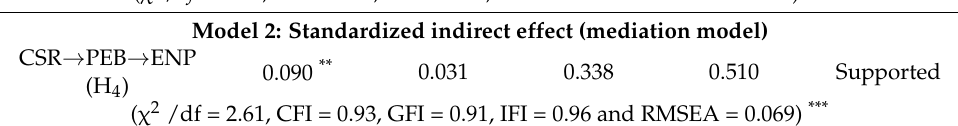
Model 2: Standardized indirect effect (mediation model)